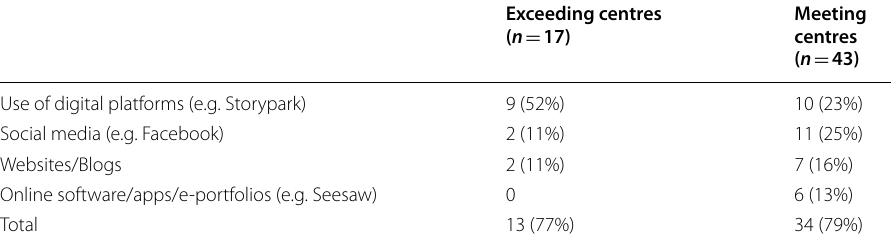
Exceeding centres Meeting ( n 17) centres = ( n 43) =